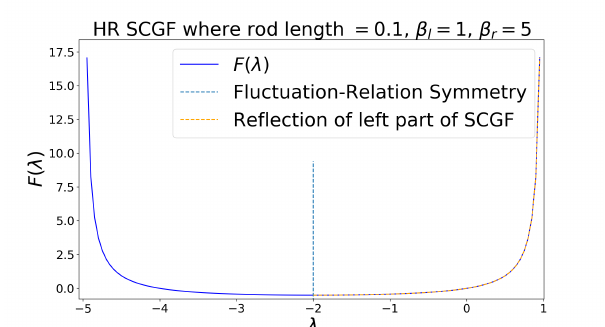
Figure 6: Plot of the energy flow SCGF for the hard rod model using equation (25). For this plot the parameters used are β again the dotted line is the expected FR symmetry point and the curve is reflected to indicate how symmetrical it